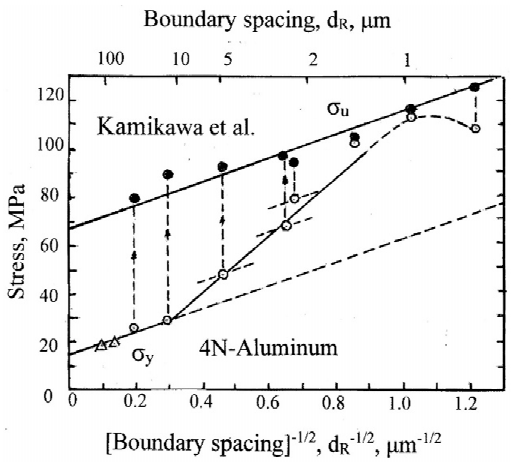
Figure 3. The yield stress, σ y , and true stress at maximum uniform strain, σ u , for aluminum material as obtained from measurements reported by Kamikawa, Hirooka and Furuhara [13].